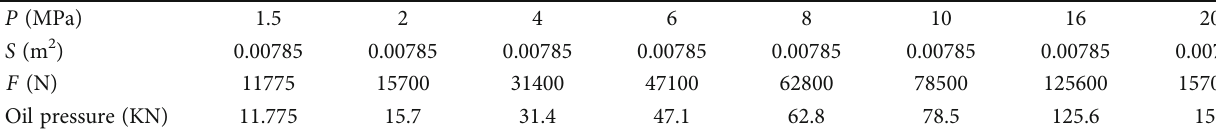
Table 2: Conversion between axial stress and oil pressure.